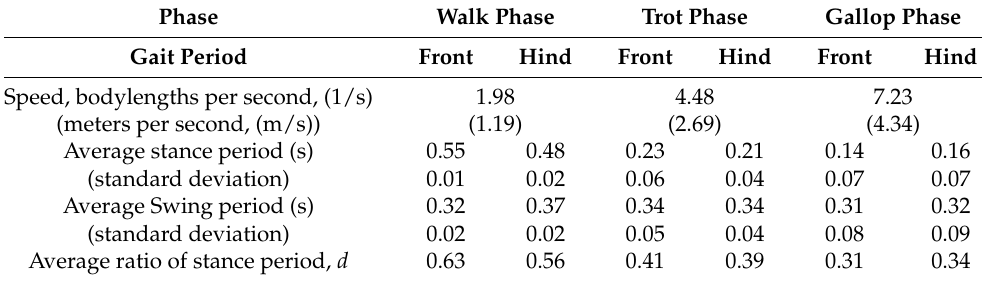
Table 1. Speed, percent of stance period, stance time, and swing time during one gait